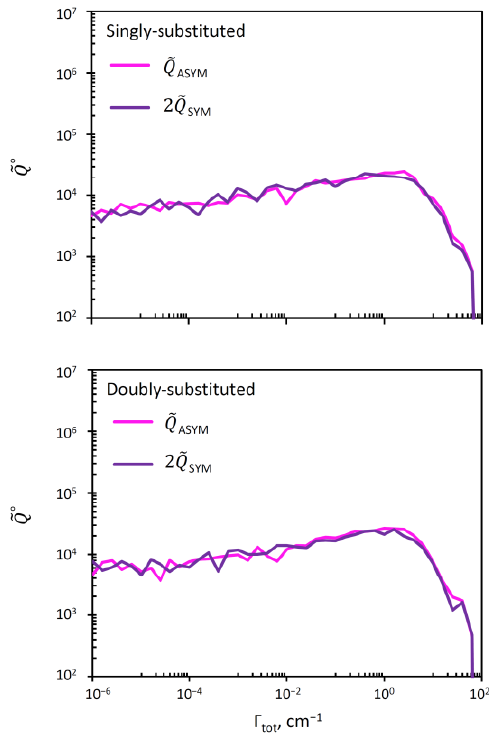
Figure 6. Distribution of resonance widths for the covalent well states in asymmetric ( pink ) and symmetric ( violet ) ozone molecules. Upper and lower frames correspond to single and double isotopic substitutions. To simplify the comparison, we plotted 𝑄̃ asym∘ and 2𝑄̃ sym∘ in order to offset the effect of symmetry.